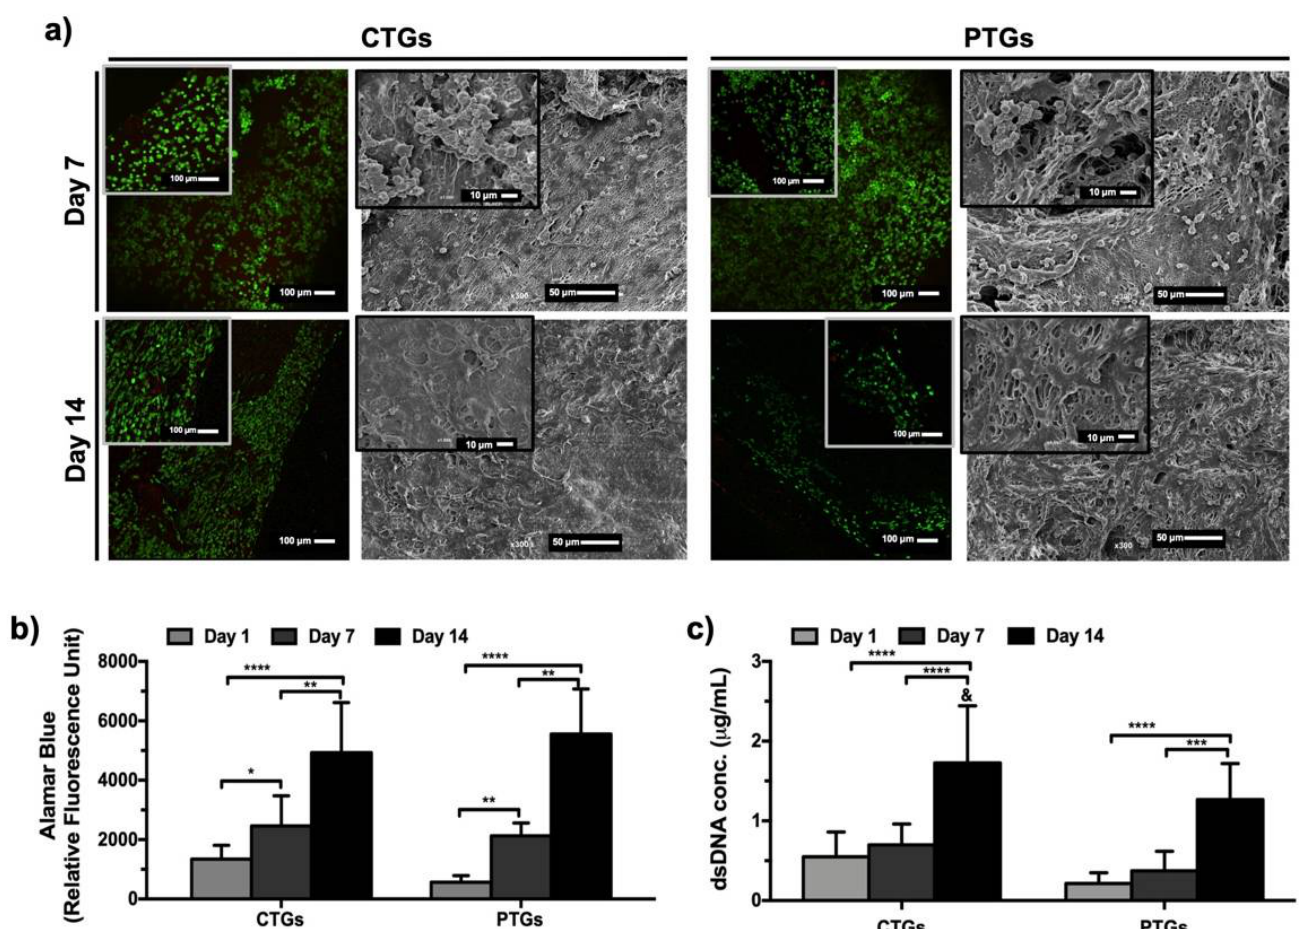
Figure 5. In vitro cell characterization. ( a ) Live/dead staining and SEM micrographs showing cell viability and morphology on the CTGs and PTG, after 7 and 14 days of culture. Living cells are stained in green and dead cells are stained in red. ( b ) Alamar blue assay detecting metabolic activity of cells, and ( c ) dsDNA quantification to analyze cell proliferation on the CTGs and PTGs, up to 14 days of culture. & Statistically significant when compared to the PTGs at the same culture period (* p < 0.05; ** p < 0.01; *** p < 0.005; **** p < 0.0001).